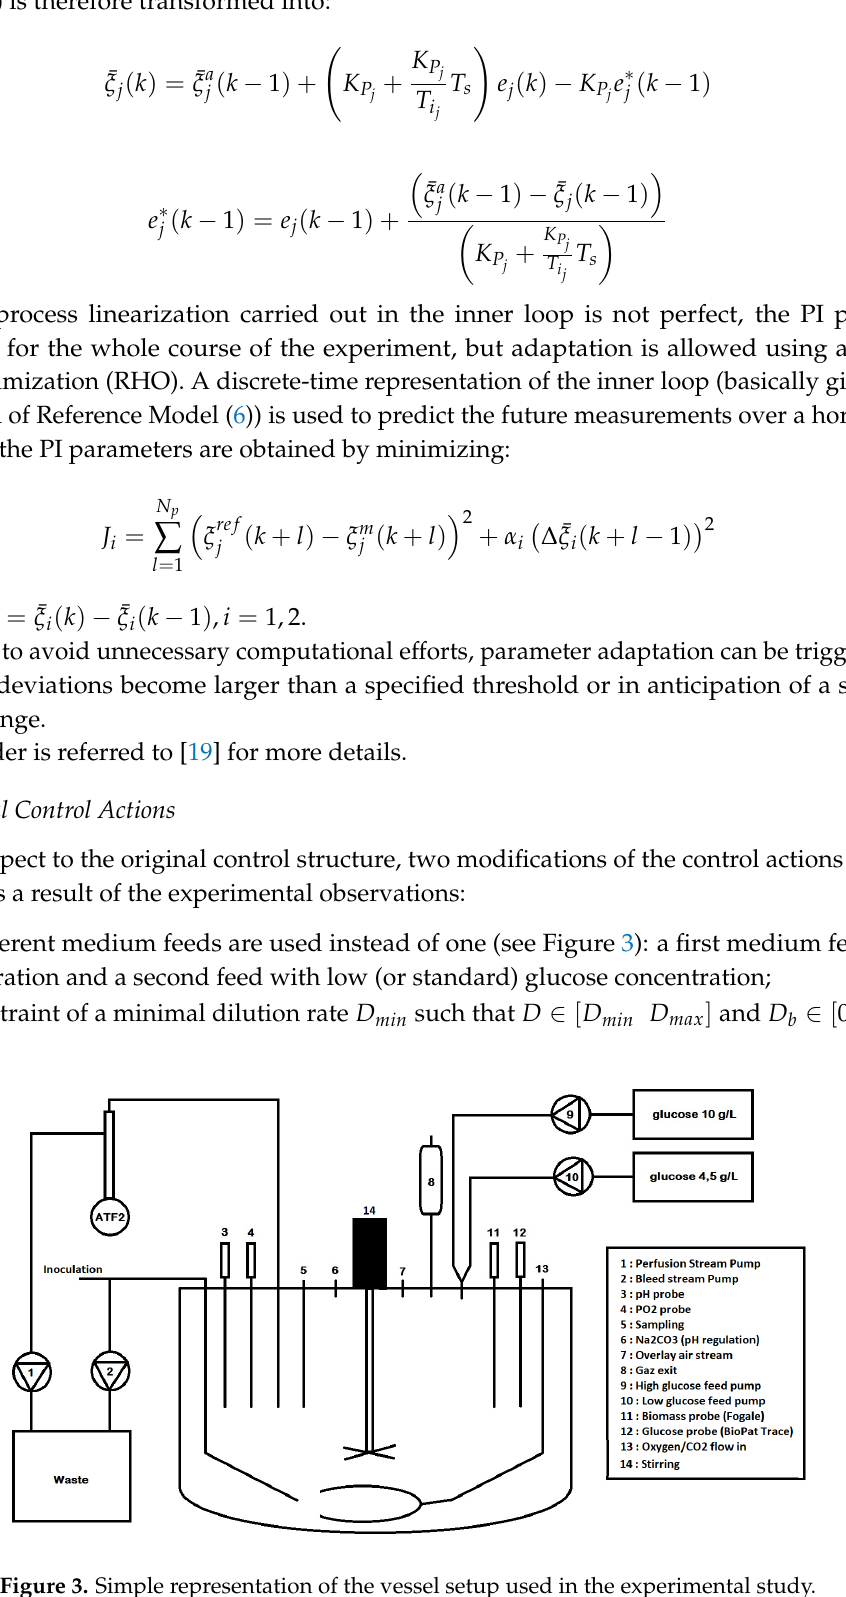
Figure 3. Simple representation of the vessel setup used in the experimental